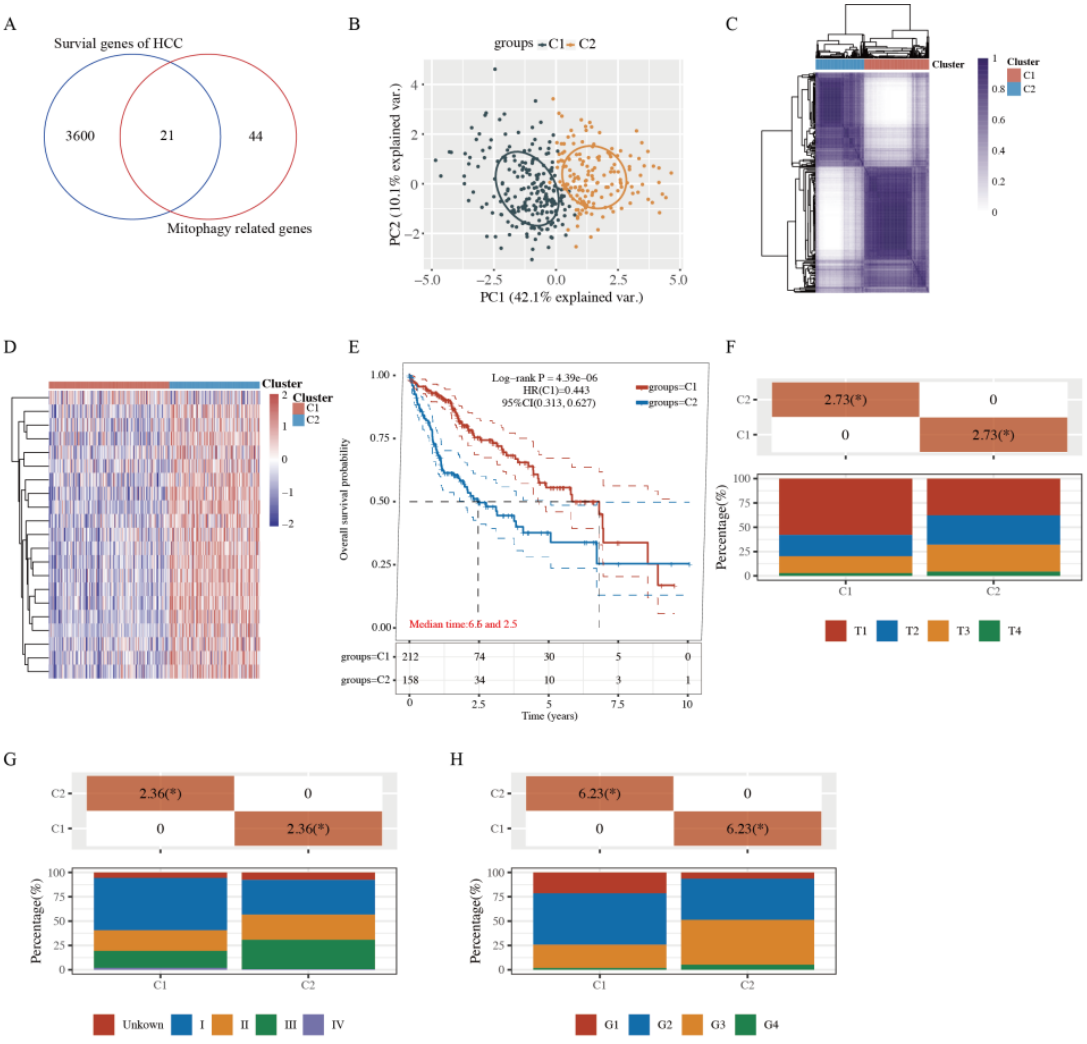
Figure 1. Tumor classification based on the mitophagy-related genes. ( A ) 21 mitophagy- and prognosis-related genes between these two groups. ( B , C ) Principal components analysis (PCA) ( B ) and consensus-clustering matrix ( C ) of 371 samples from the TCGA dataset for k = 2. ( D ) Heatmap of mitophagy-related gene expression in different clusters (C1, C2). Red represents high gene expression, and blue represents low expression. ( E ) The Kaplan–Meier curve of overall survival of patients with HCC in two clusters. ( F ) The degree of progression of the primary tumor (T) at diagnosis in the two clusters. ( G ) Distribution of stage at diagnosis in the two clusters. ( H ) The grades ( G ) of tumors in the two clusters. * indicates a significant difference in the distribution of the clinical features between the two groups ( p < 0.05).